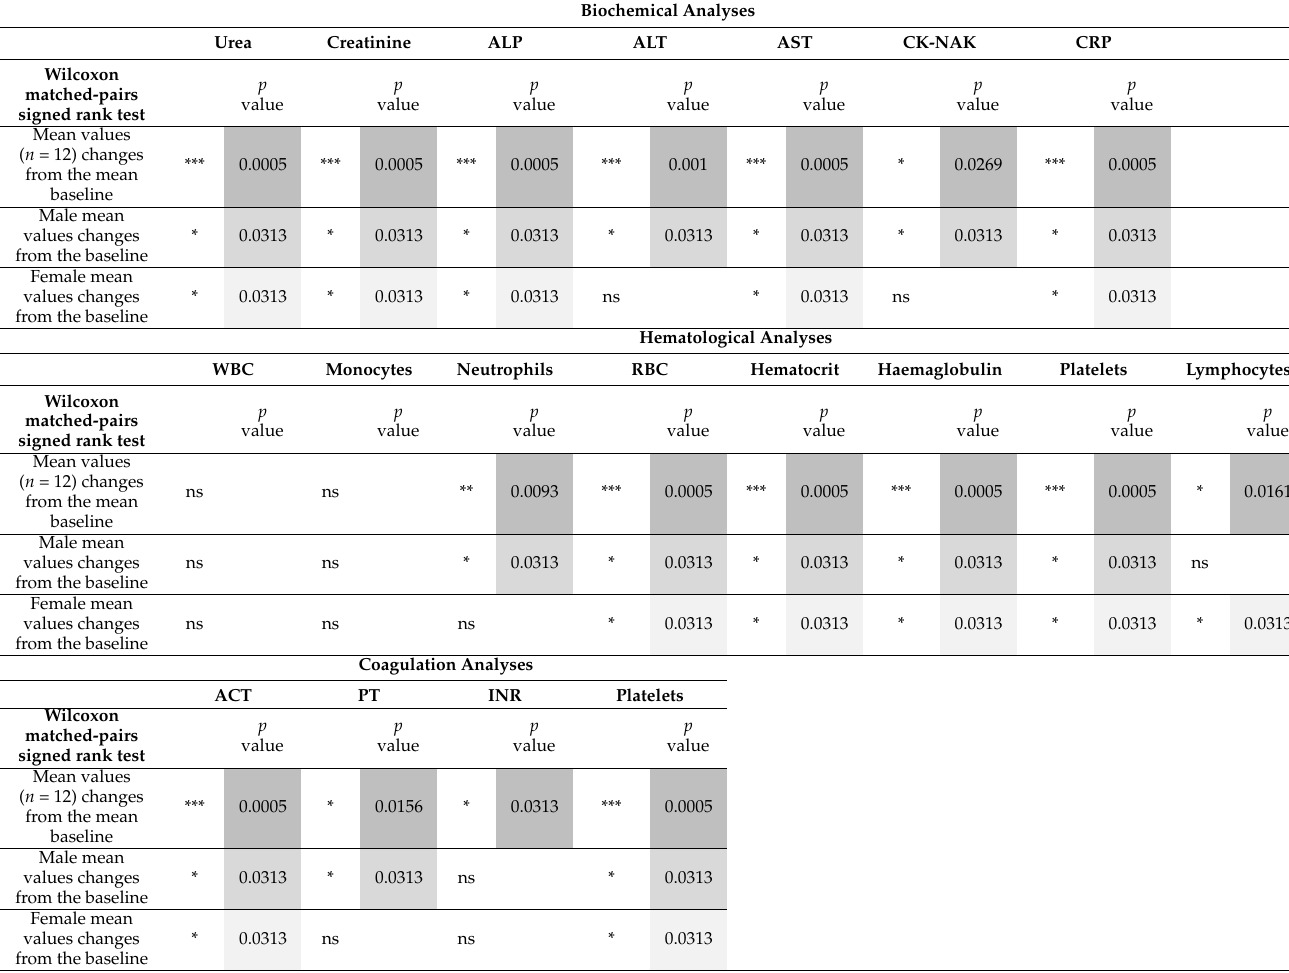
Table 5. Statistical analyses of the clinical pathology changes from the baseline values in terminal samples of SUDV-challenged animals. To determine statistically significant changes at the time of euthanasia the mean of terminal values were compared to the mean of baseline-value using the Wilcoxon matched-pairs signed ranks tests. Mean values of the complete group of animals ( n = 12), of the group of male animals ( n = 6) and of the group of female animals ( n = 6) have been considered. Differences from baseline were considered to be statistically significant at p -values <